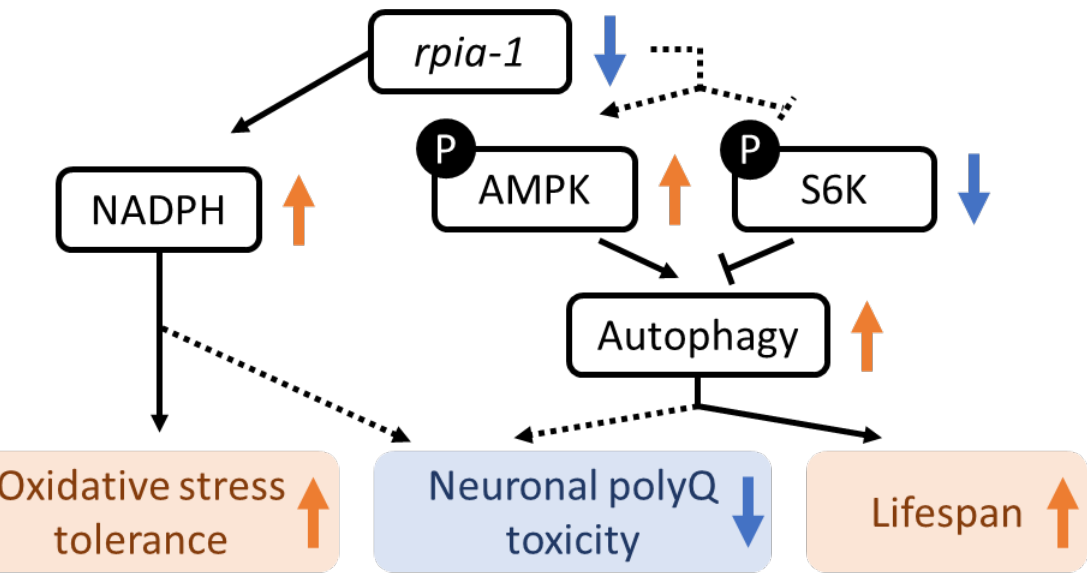
Figure 8. The mechanism of rpia-1 -mediated lifespan regulation and oxidative stress response in C. elegans. The down-regulation of rpia-1 results in the elevation of NADPH level, which also benefits oxidative stress tolerance improvement. Moreover, according to previous studies, the elevation of NADPH might benefit the amelioration of aggregated neuronal polyQ implying that rpia-1 reduction-induced neuronal polyQ aggregation alleviation might be attributed to NADPH level. Still, further experiment is required. In addition, rpia-1 reduction positively regulates the AMPK pathway and negatively regulates the TOR pathway, which induces autophagy and eventually leads to lifespan extension in C. elegans. Besides lifespan extension, the neuronal polyQ aggregation might also be alleviated by rpia-1 -mediated autophagy induction.